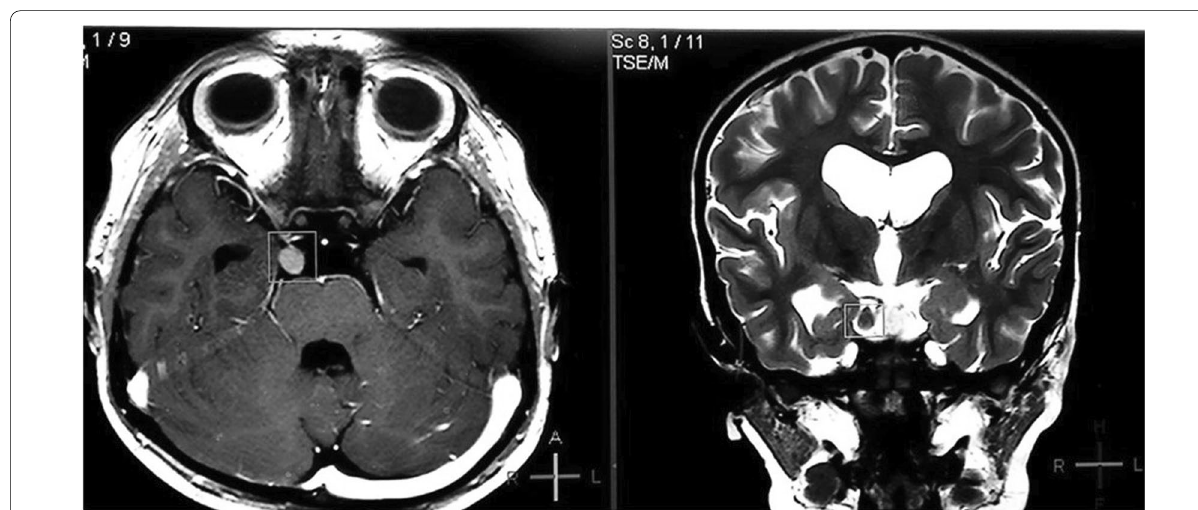
Fig. 2 MRI brain images showing soft tissue intensity appearing nearly iso-intense to gray matter on T1- and T2 weighted images with dense homogenous post contrast enhancement without peri-focal edema of right oculomotor nerve